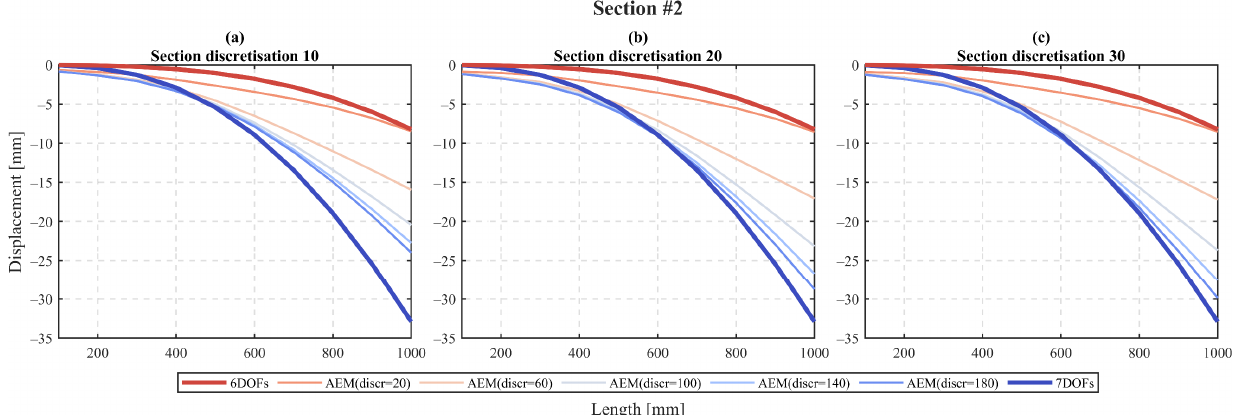
Figure 5. Vertical displacement–length relation for Section #2 with the different discretisation configurations.